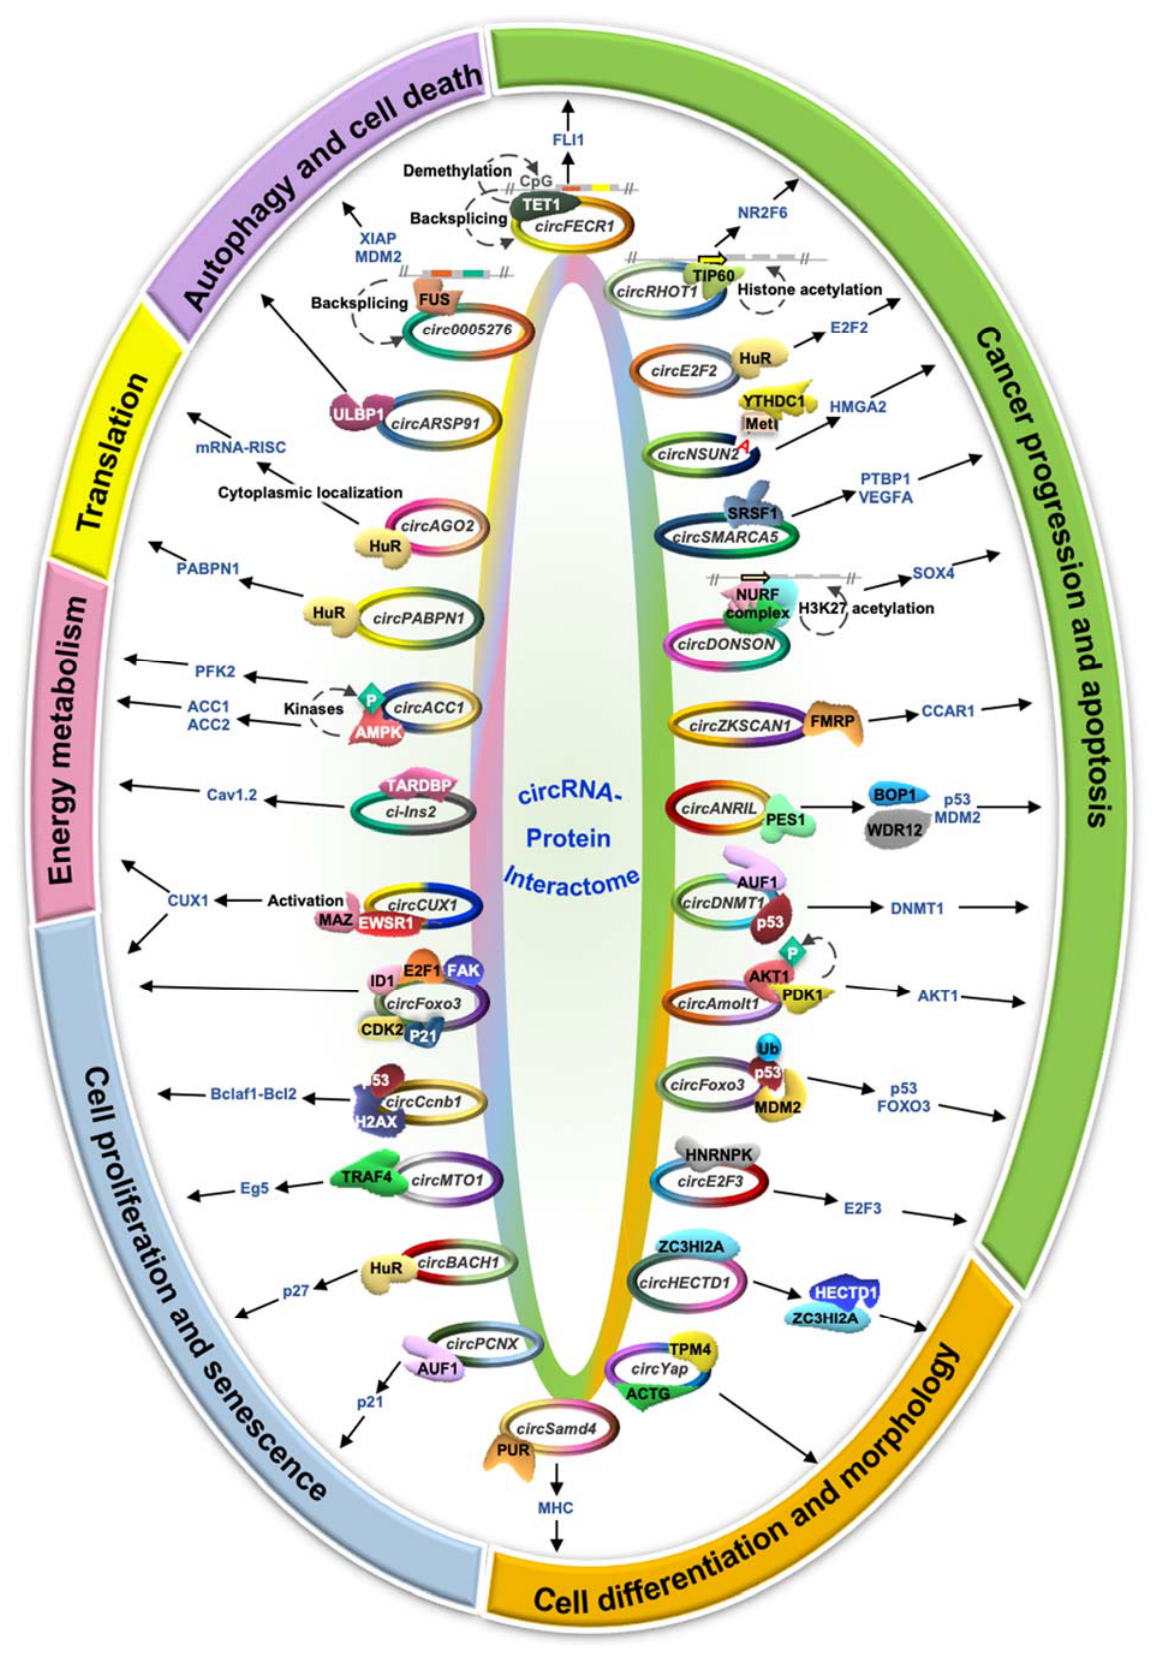
Figure 3. Schematic representation of circRNA–protein interactions and their implications in pathology and cellular physiological conditions.